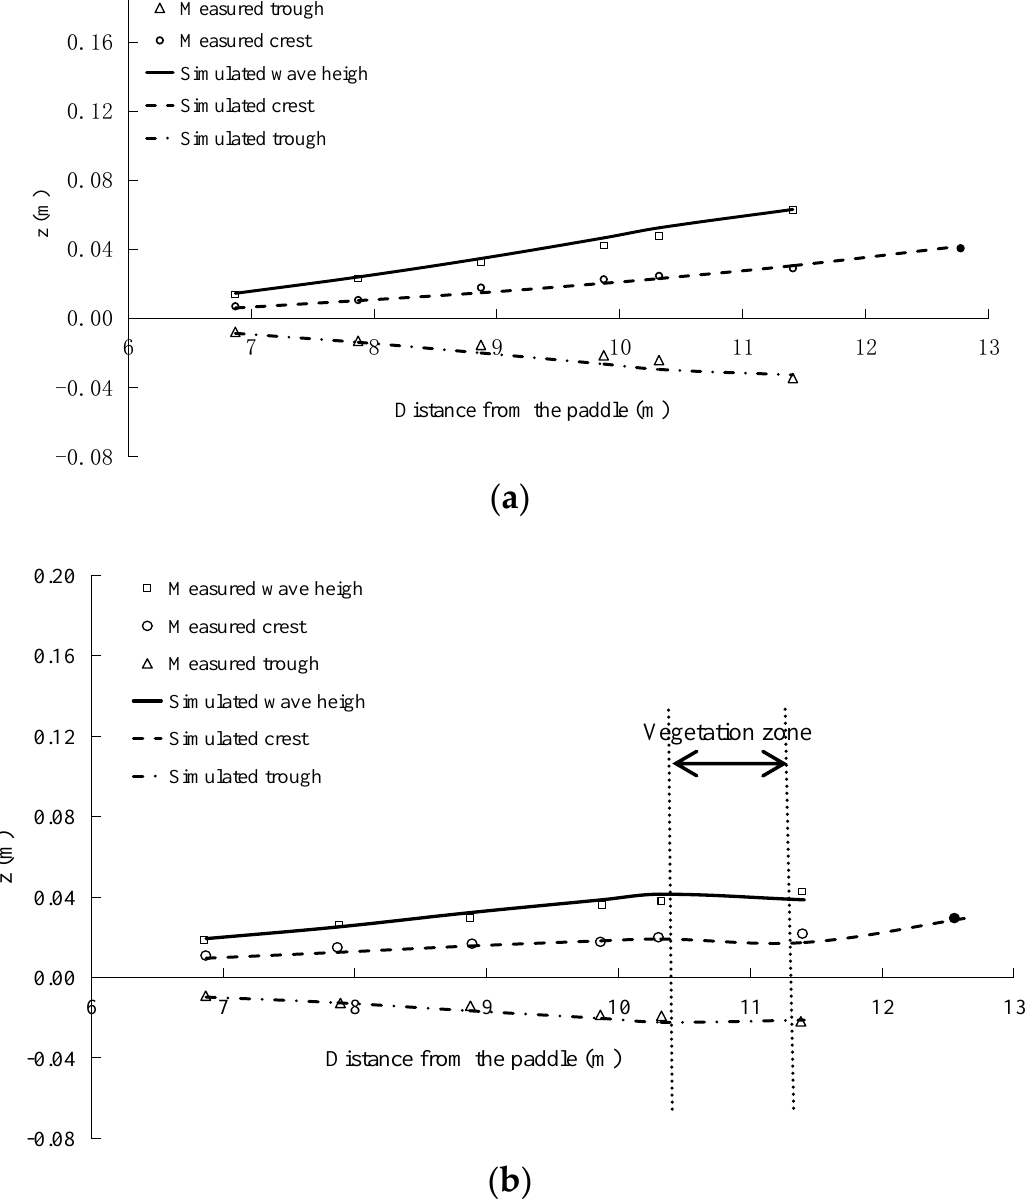
Figure 6. Comparison of measured and calculated wave crests, heights, and troughs. ( a ) Case without vegetation, ( b ) Case with full vegetation.